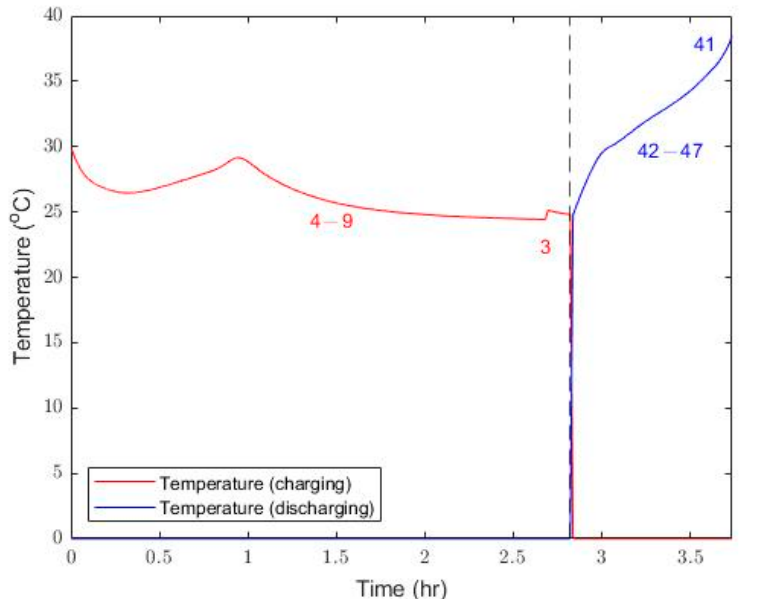
Figure 7. Features in the charging stage.